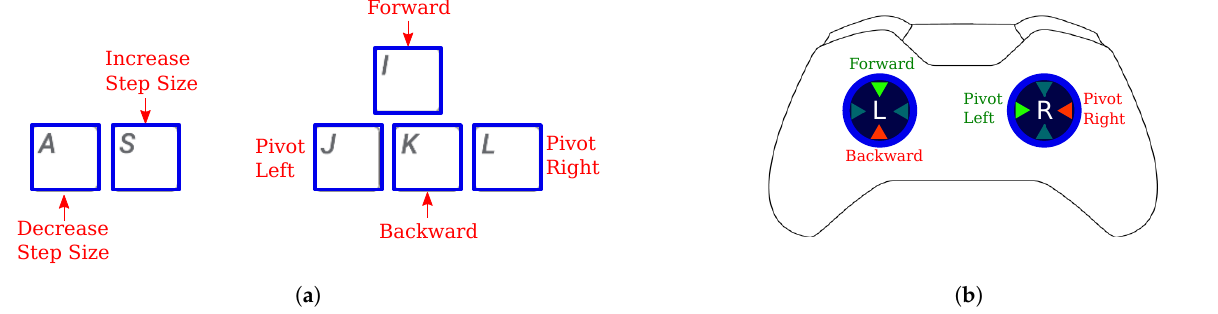
Figure 9. Evaluated operator interfaces to be compared against the proposed haptic interface H ( a ) keyboard layout for operator interface K ( b ) game controller mapping for operator interface J